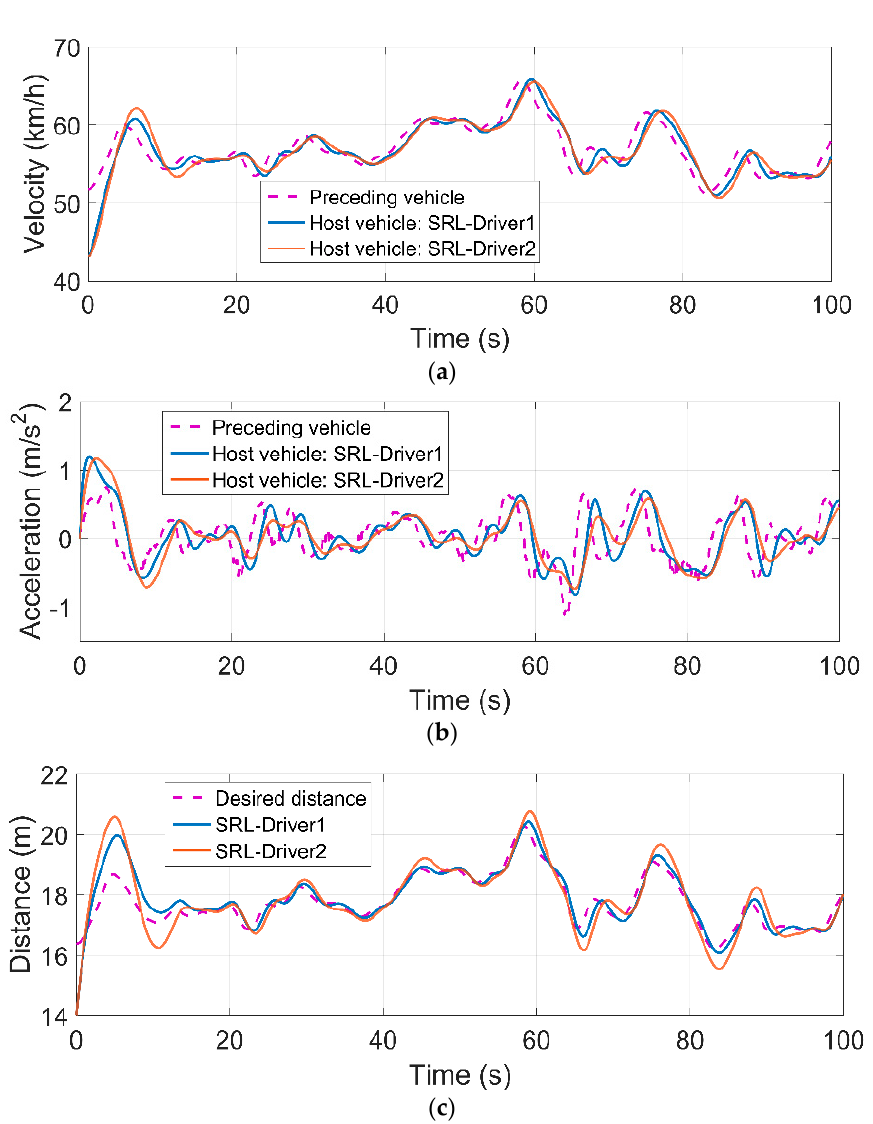
Figure 7. Simulation results with the real driving cycle: ( a ) velocity, ( b ) acceleration, and ( c ) distance. Table 4. Maximum, average, and variance of distance error, with the real driving